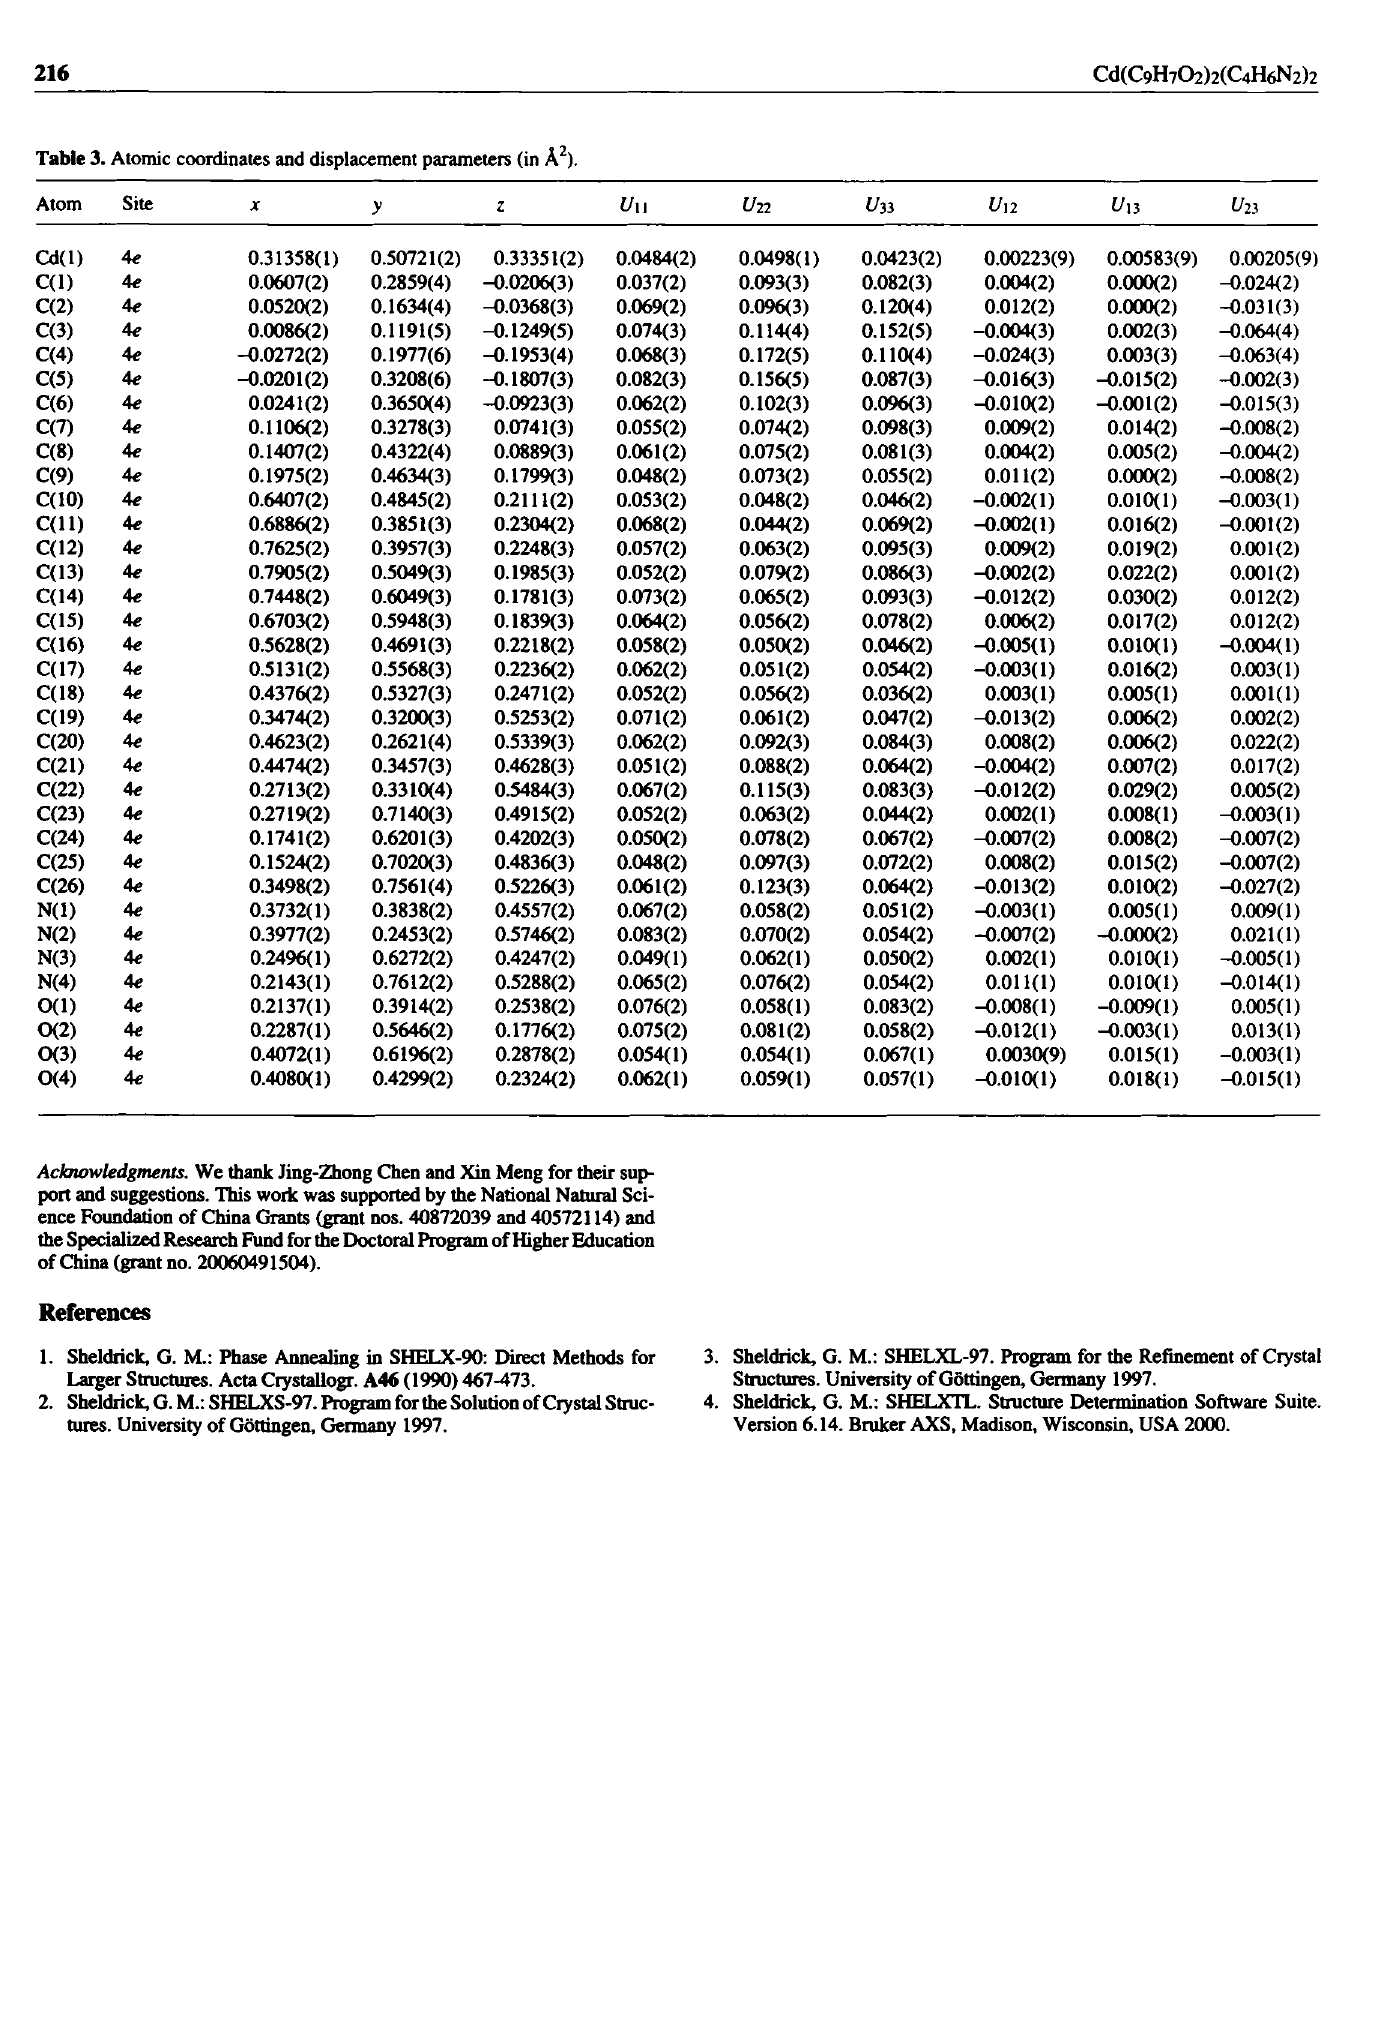
Table 3. Atomic coordinates and displacement parameters (in Â 2